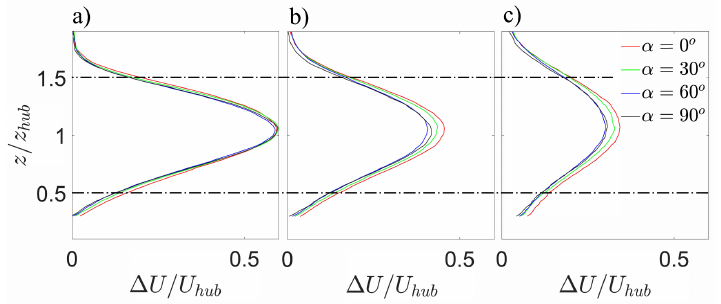
Figure 7. Profiles of normalized mean streamwise velocity deficit, ( U inc − U )/ U hub , for the wake flow at x / d T = ( a ) 2, ( b ) 3, and ( c ) 4 . The dash-dotted lines refer to positions of the upper and lower blade tips. The comparison between measured (solid line) and modeled (dashed line) hub-height